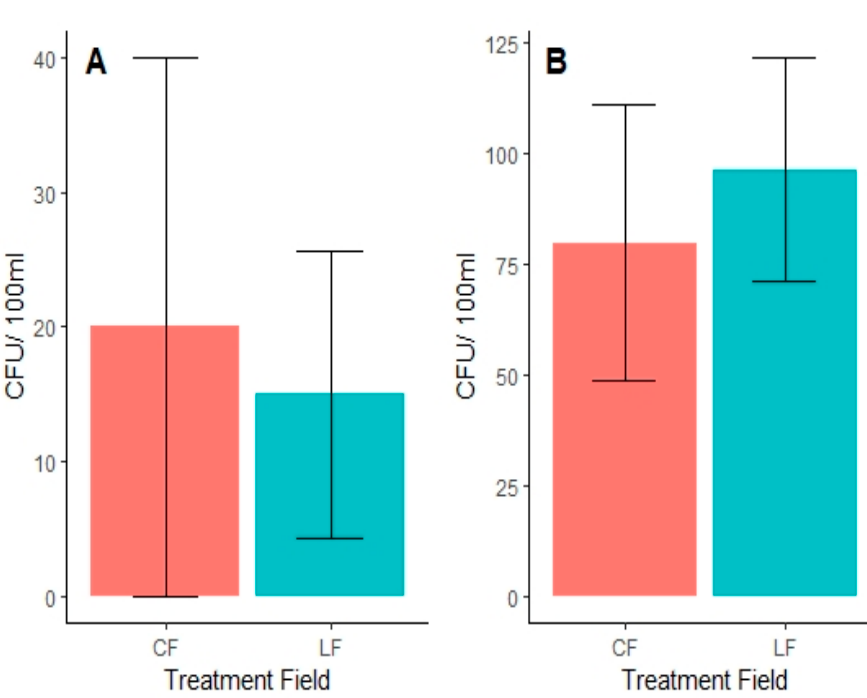
Figure 2. Escherichia coli and C. perfringens detection in water ± SE. ( A ) E. coli detection in water samples; bars denoted standard error (SE) of means. Results reported in CFU/100 mL. ( B ) C. perfringens detection in water; bars denote SE. Results reported in CFU/100ml. No significant differences between treatment fields. Tallahatchie and Leflore County, Mississippi, March 2018.